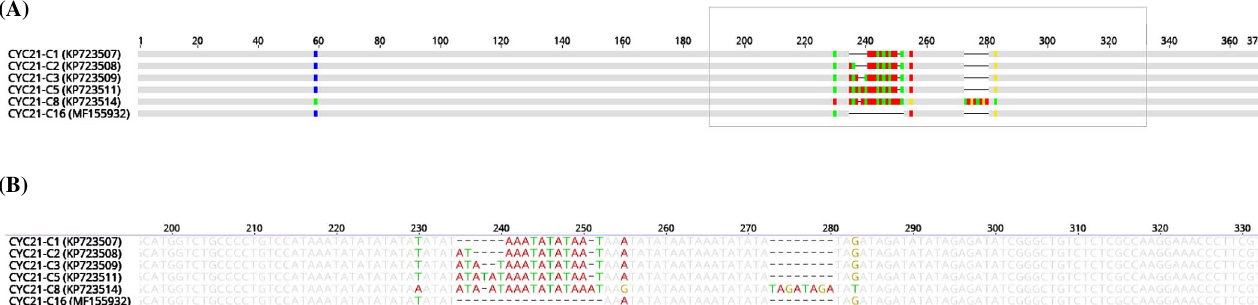
Figure 1. CYC21 sequence types. (A) Nucleotide polymorphisms among fi ve of the previously identi fi ed CYC21 sequence types [4] and the newly identi fi ed sequence type C16. (B) Sequence detail of the boxed area in Panel A.